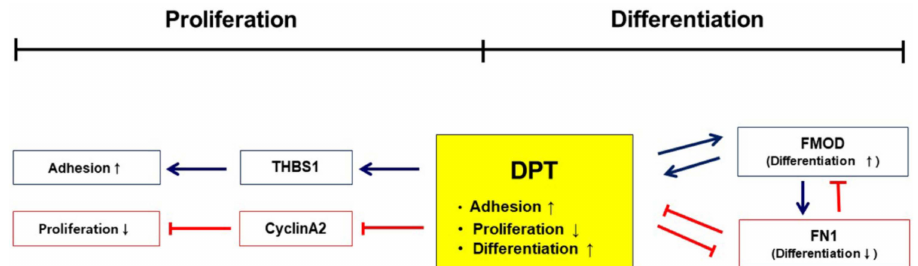
Figure 8. Schematic representation of DPT e ff ects in myogenesis. A representation of the diverse role of DPT in myogenesis is shown. DPT enhances the cell adhesion by inducing THBS1, and decreases cell proliferation by inhibiting Cyclin A2. A demonstration of the interrelationship between DPT, FMOD, and FN is also